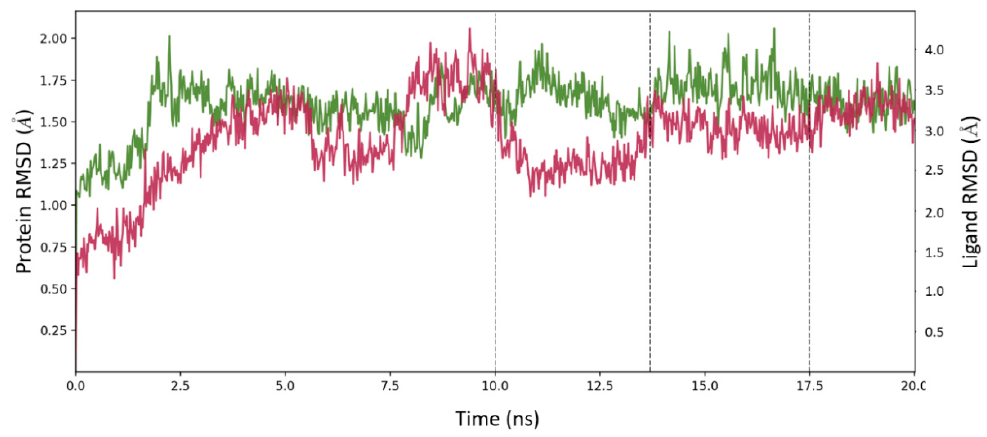
Figure 6. Plot of the MOC-24 root mean square deviation (RMSD) (red, right Y scale) and NS3 protein backbone RMSD (green, left Y scale) against simulation time. The dashed lines indicate distinct phases of protein and ligand conformation evolving over the simulation time.